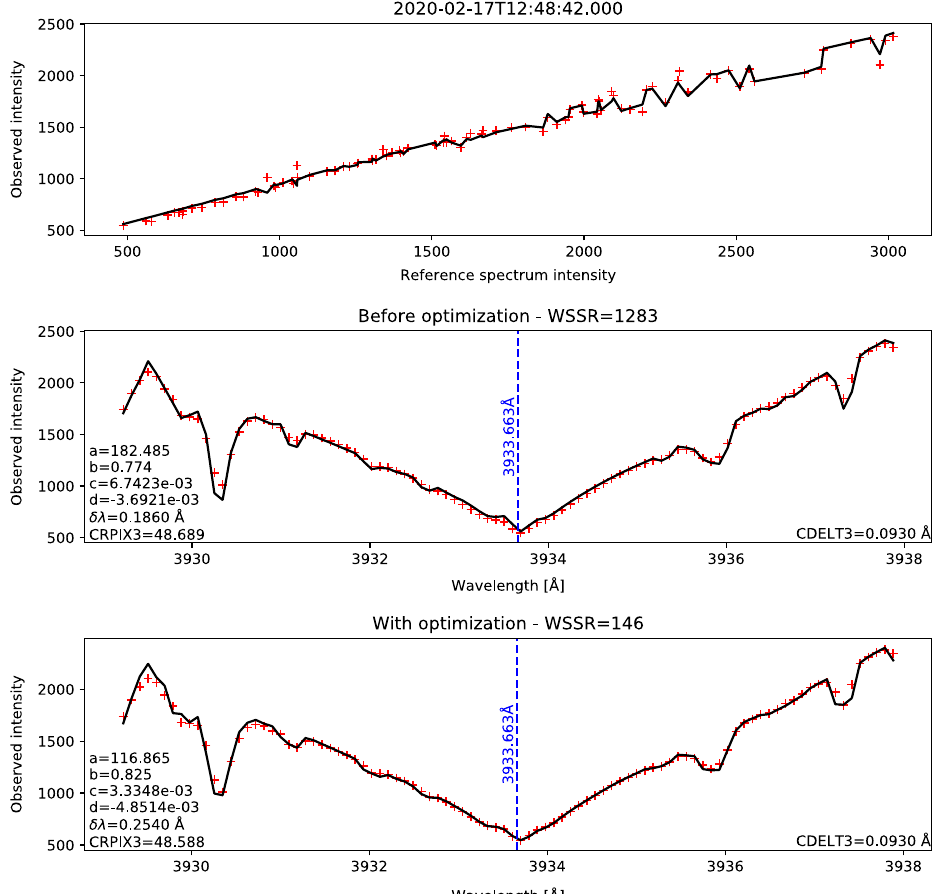
Fig. 9. Example of wavelength calibration of CaII K spectral line. The red crosses represent the observed disk-integrated intensities S obs ^ S ^ S (Eq. (1)). The black lines are the scaled smoothed reference spectrum obs (Eq. (5)). Top panel: S obs and obs are plotted as a function of the (cid:1) S ^ S intensities of the smoothed reference spectrum ref (Eq. (3)). Middle and bottom panels: S obs and obs are plotted as a function of wavelength. The coef fi cients a , b , c and d of the fi t are shown. The vertical blue line gives the line core position at k c = 3933.663 Å. The corresponding FITS index is given by CRPIX3. The interval over which the reference spectra is smoothed is given by dk . WSSR is the resulting weighted sum of squared residuals. The top and middle panels give the fi t with the initial parameters and the bottom panel gives the fi t and parameters after optimization (lower